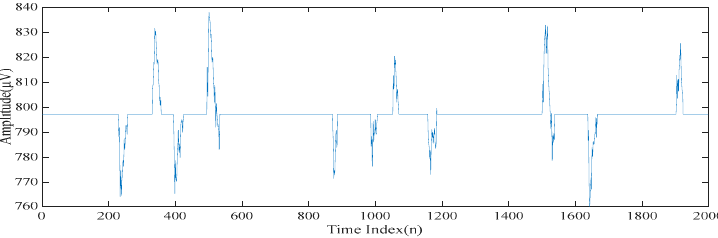
Figure 3. The locations of the spikes that need to be suppressed.